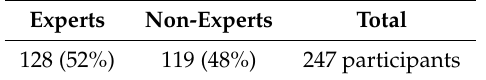
Table 15. Numbers of Experts and Non-experts in this study.